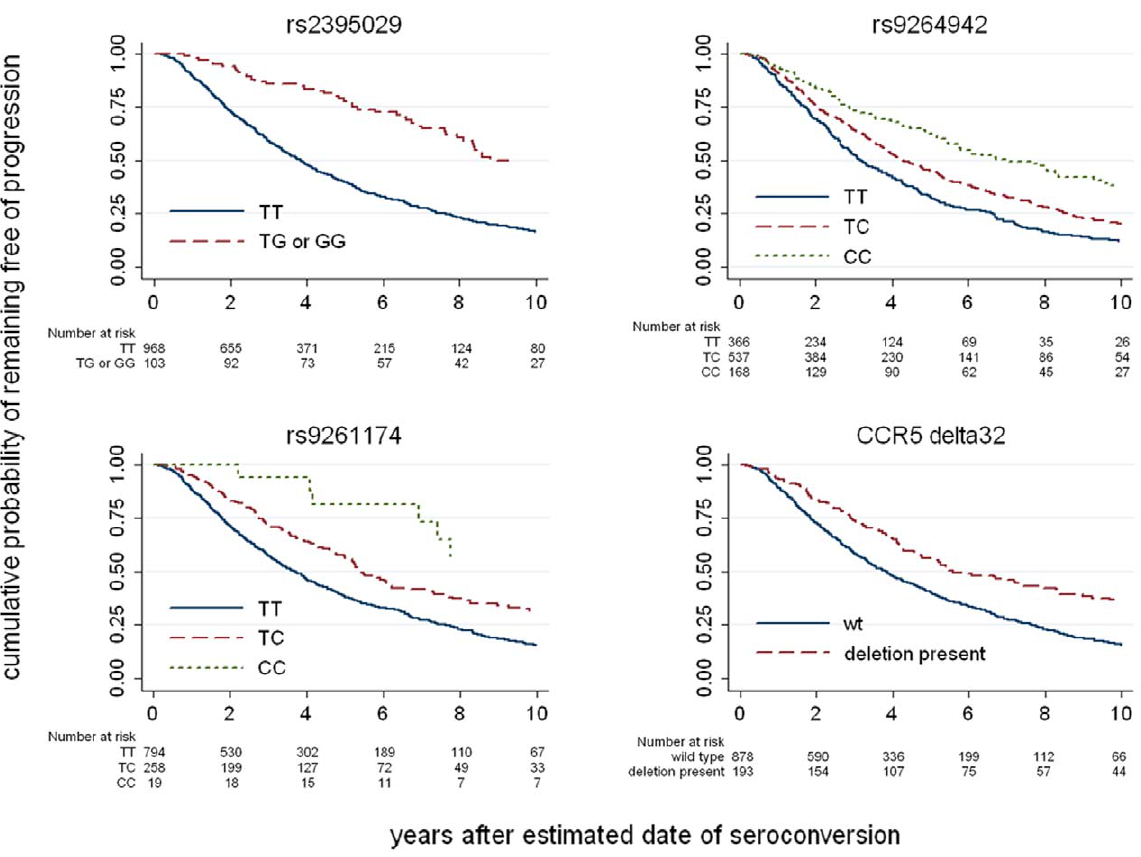
Figure 3. Kaplan-Meier survival estimates for the top associated variants. Results are shown for the 3 most associated SNPs indentified in the genome-wide progression scan and for CCR5 - D 32. The survival curves show, for each genotype, the proportion of the individuals that do not reach a progression outcome over the first 10 years after seroconversion.